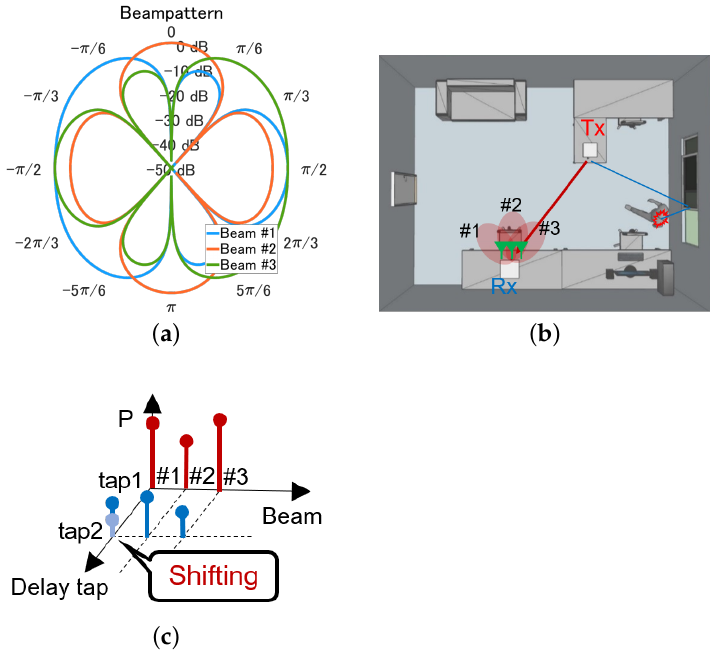
Figure 11. Concept of the proposed method. ( a ) Beam pattern. ( b ) Event detection. ( c ) Multipath